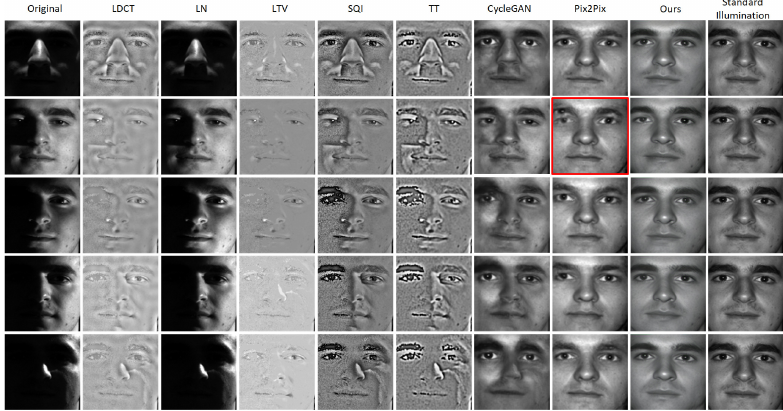
Figure 6. Comparisons between the LDCT [3], the LN [4], the LTV [5], the SQI [6], the TT [7], the CycleGAN [13], the Pix2Pix [16] and ours on the YaleB database. The first column: original poor-lighted face images. The second to ninth columns: synthesized results of the original poor-lighted face